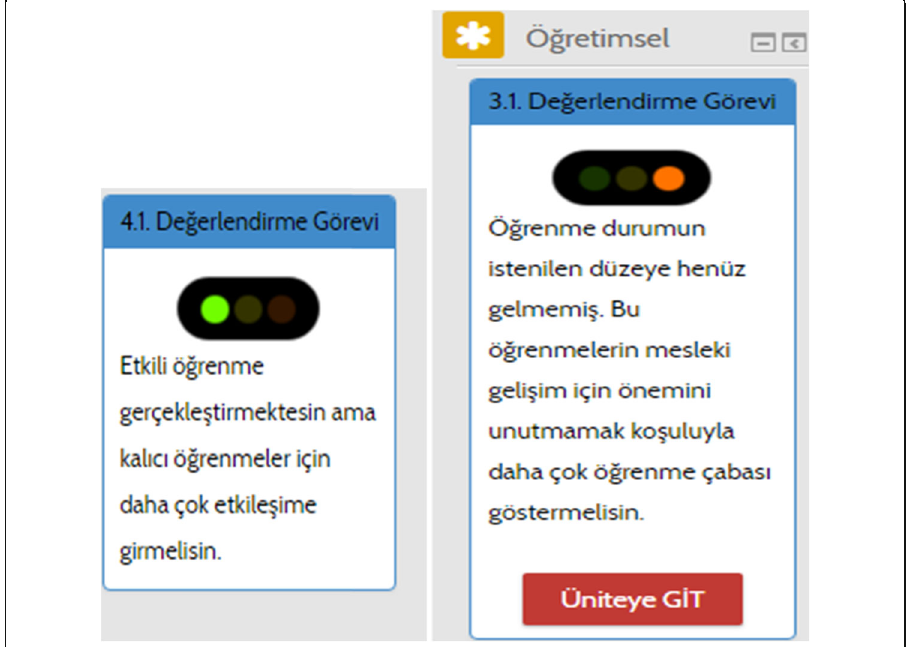
Fig. 3 Examples of Instructional